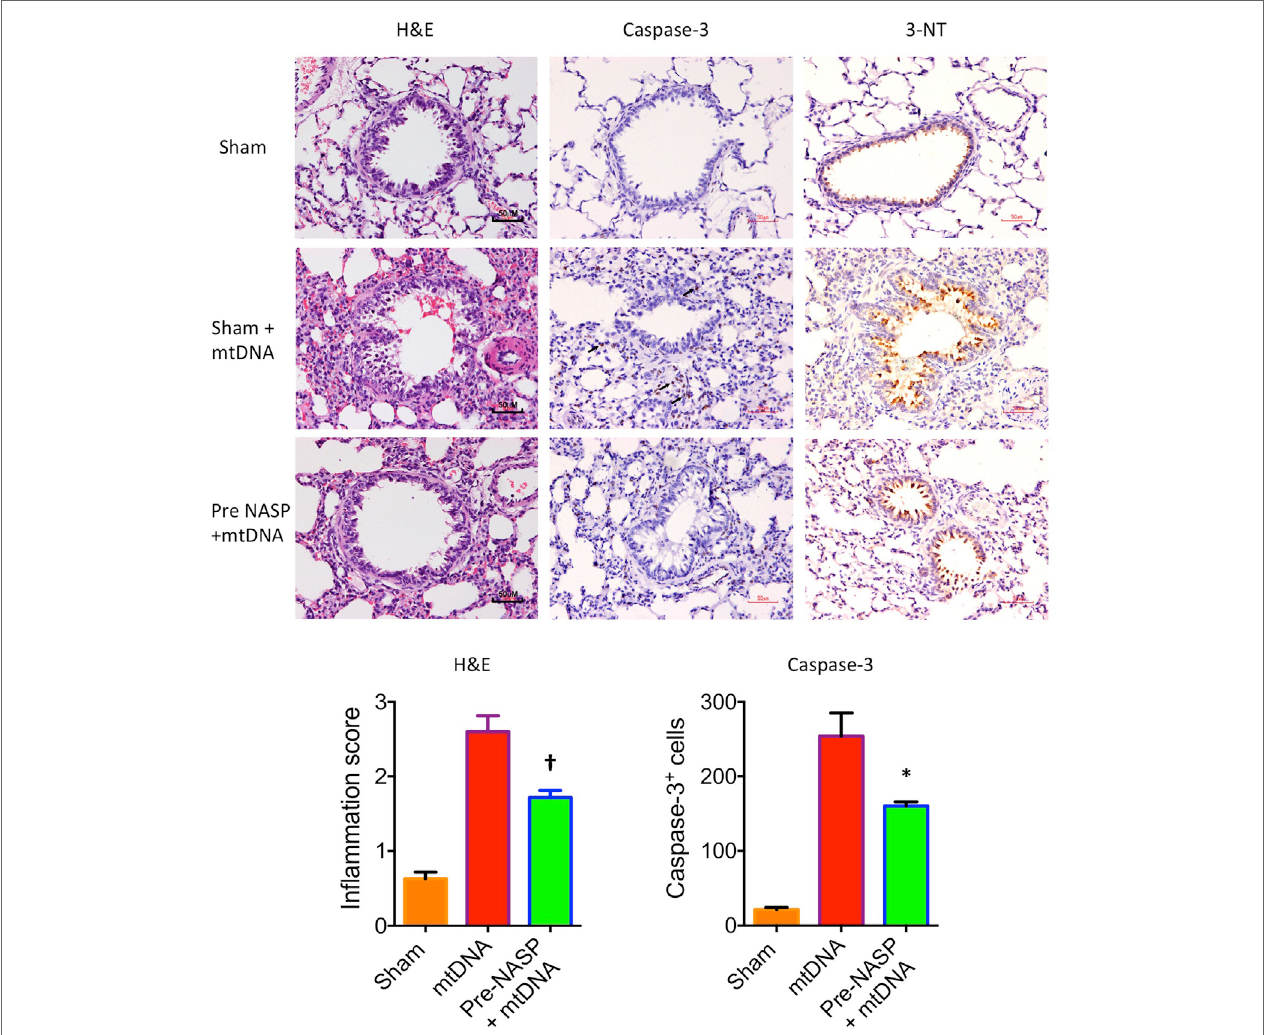
FigUre 11 | Nucleic acid scavenging polymer (NASP) (hexadimethrine bromide) 2 mg/kg pretreatment followed by 5% liver pure mitochondrial DNA (mtDNA) injections into sham animals attenuated lung injury on histological examination with hematoxylin & eosin (H&E), caspase-3M and 3-Nitrotyrosine (3-NT) staining. * denotes p < 0.05, † denotes p < 0.01, both vs pure mtDNA injection alone, t -tests. n = 3–5 animals per group. Mean values with SEM bars